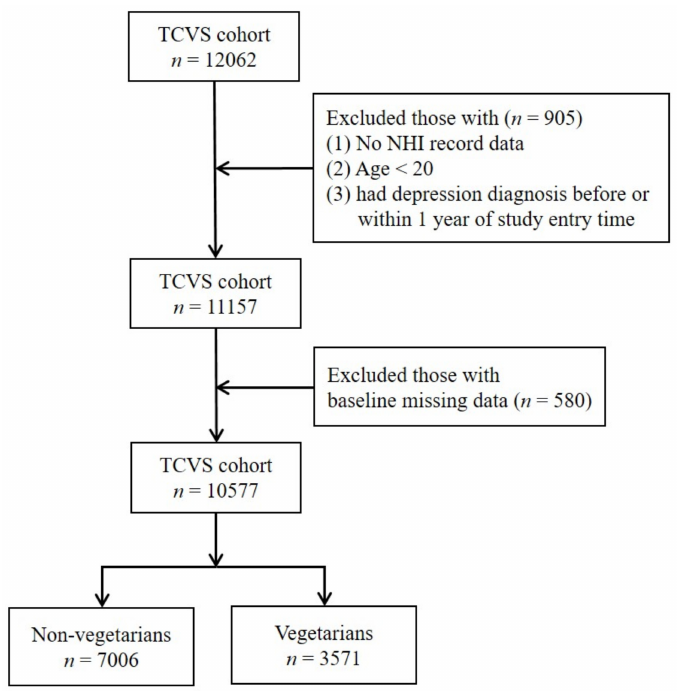
Figure 1. The flowchart of data